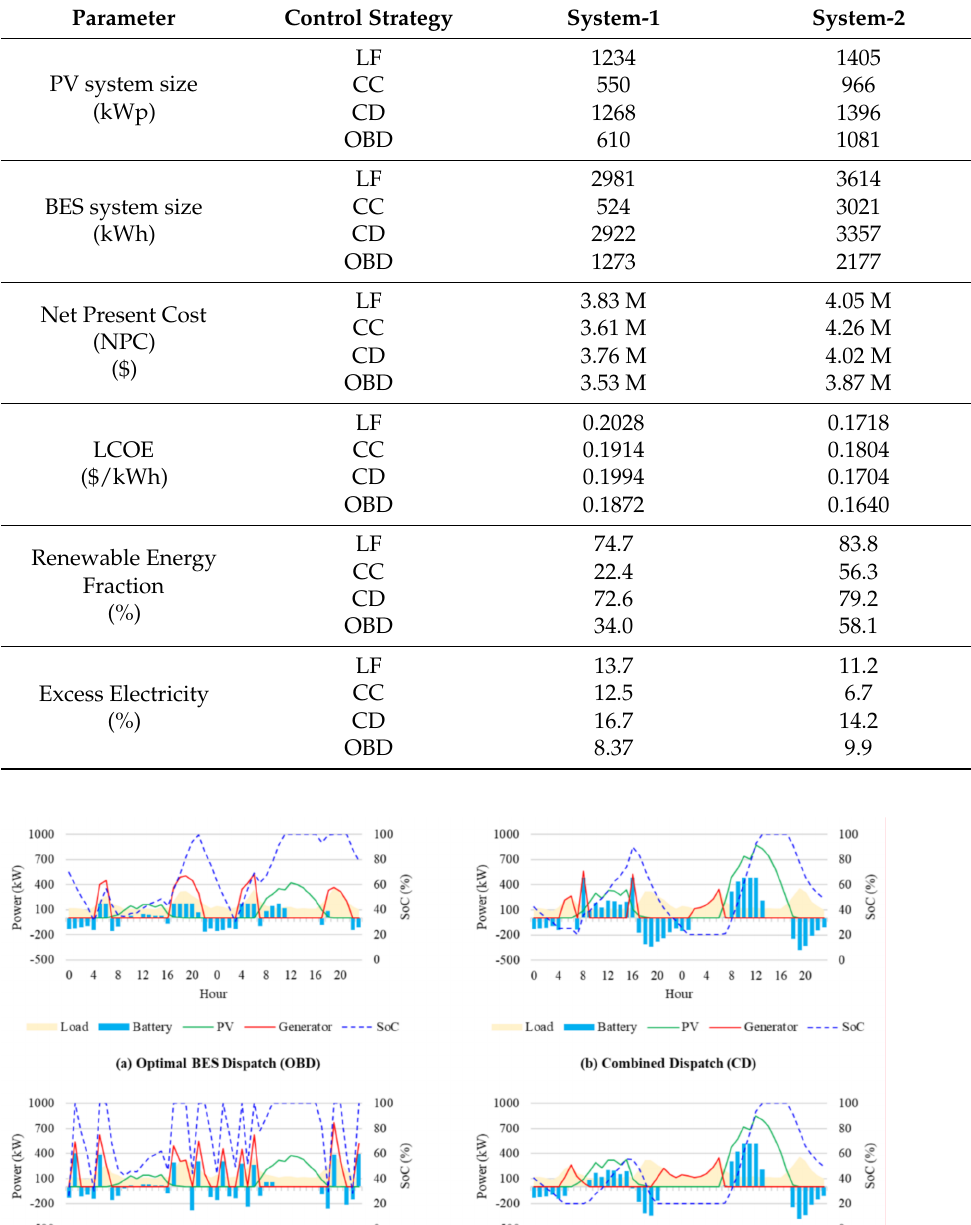
Table 2. Optimized Simulation Results. The results compare the PV and BES size, Net Present Cost (NPC), LCOE, renewable fraction, and excess electricity between the control strategies applied in System-1 and System-2.